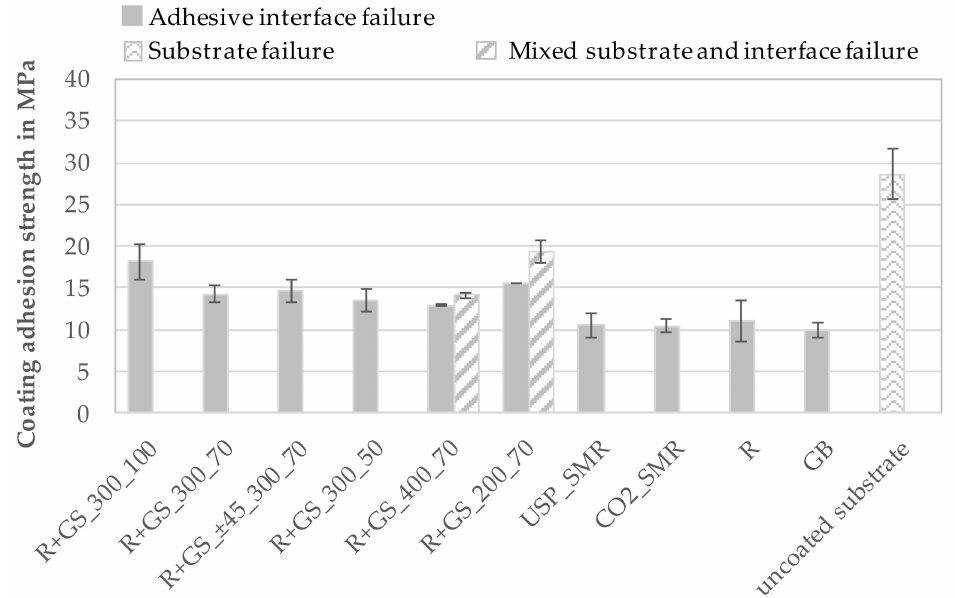
Figure 12. Coating adhesion strengths of wire arc copper coated CFRP with different surface pre- treatments under shear tensile test; the influence of the fracture modes on the coating adhesion strength are indicated by different bar